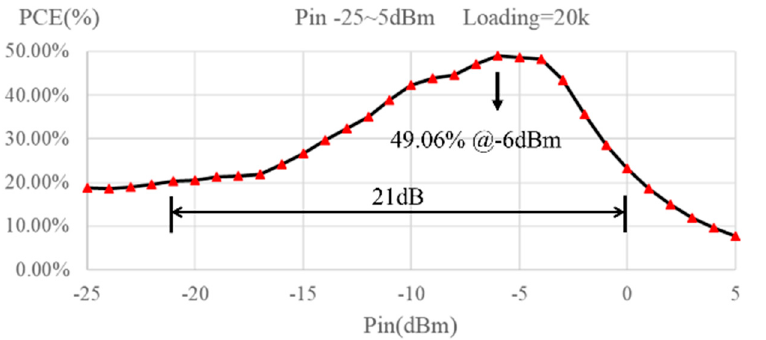
Figure 12. PCE measurement under different loading.